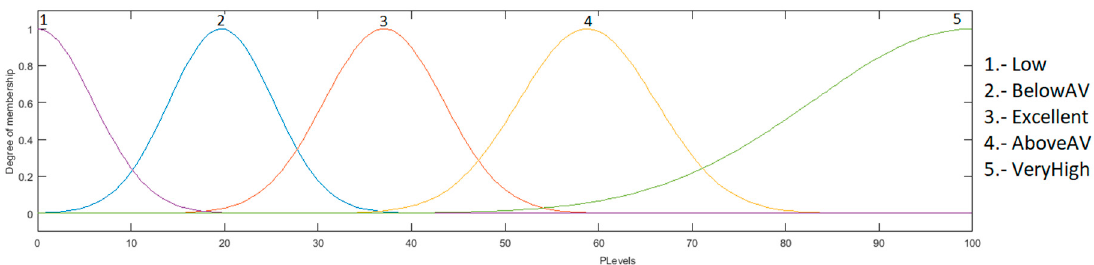
Figure 9. Output heart rate level.